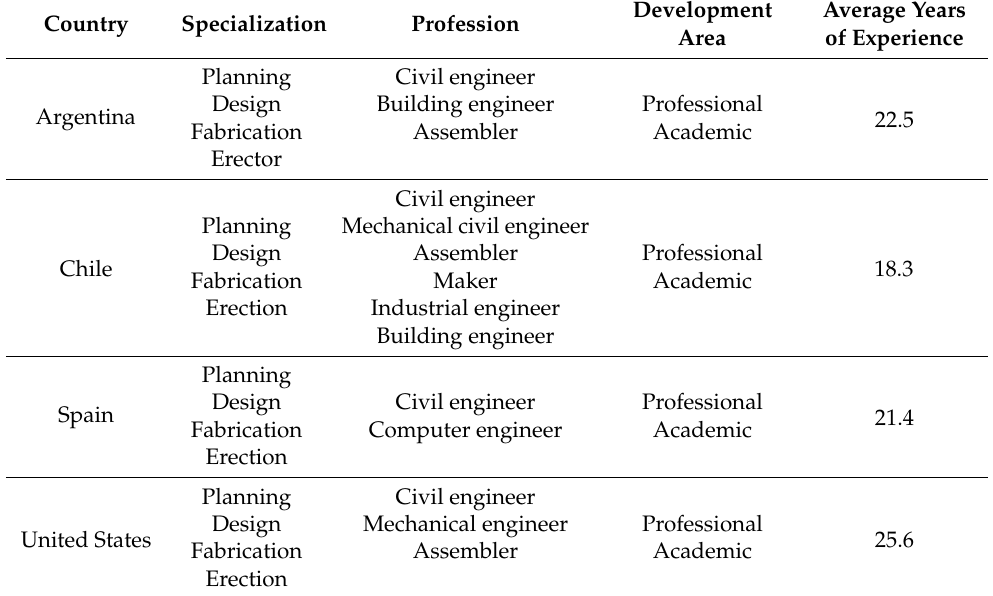
Table 3. Panel of